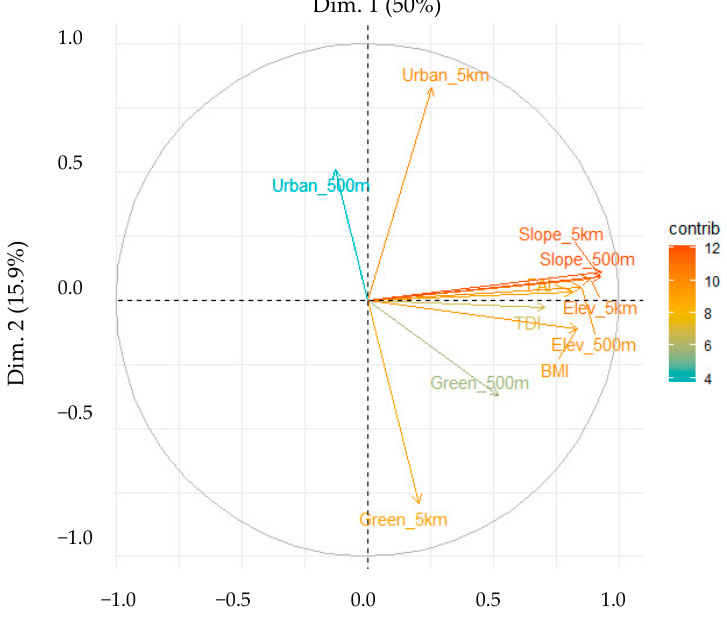
Figure 3. Principal component analysis biplot for the first two principal component scores.